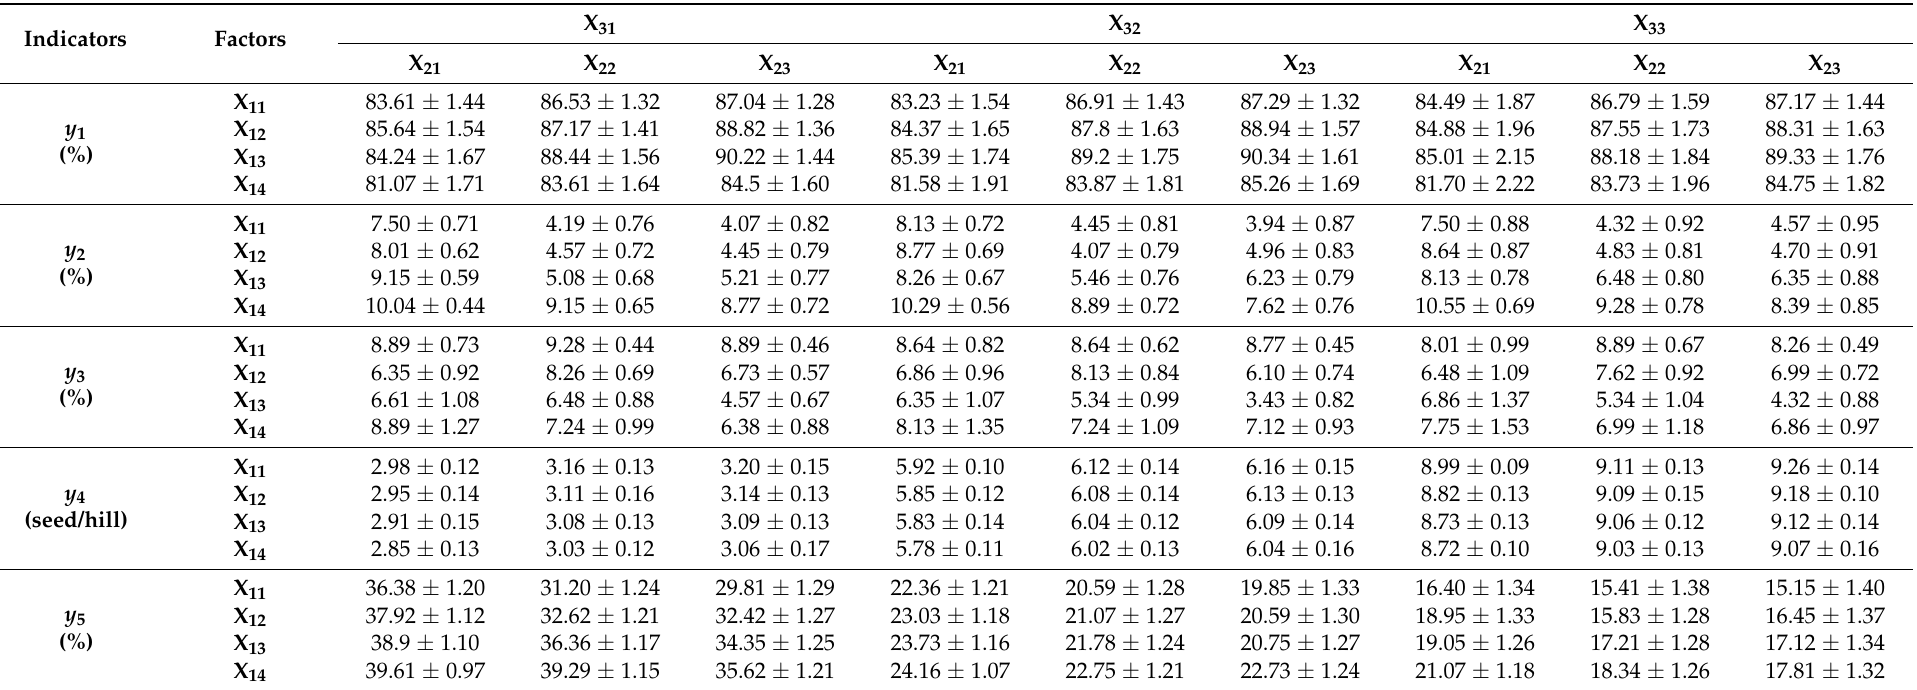
Table 3. Experimental